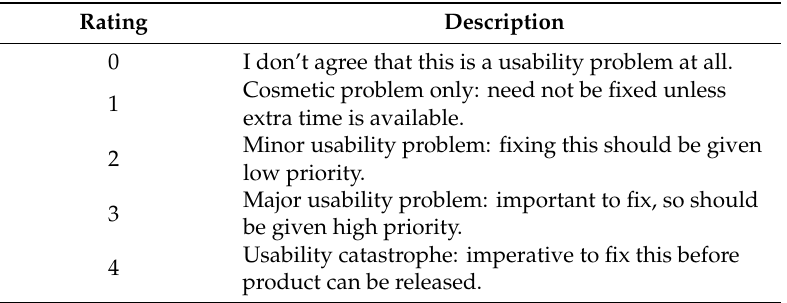
Table 4. Scheme of severity rating applied, following Nielsen